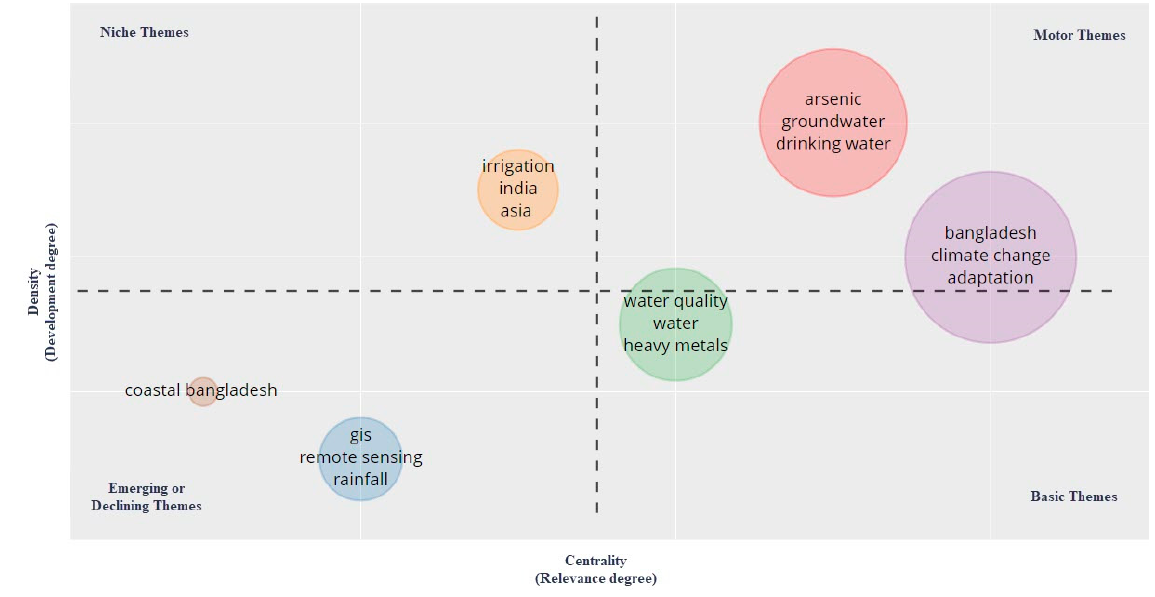
Figure 5. Thematic map of Bangladesh water-research-related publications.